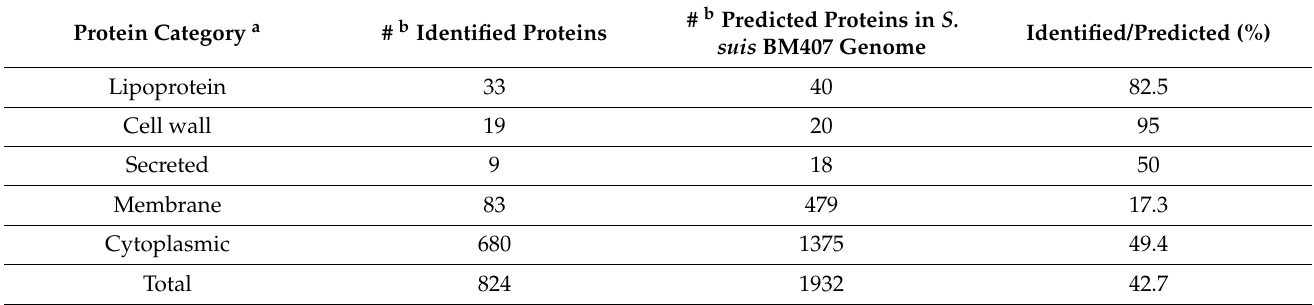
Table 1. Summary of the proteins in the exoproteomes of the six Streptococcus suis human clinical isolates, identified by GeLC-MS/MS